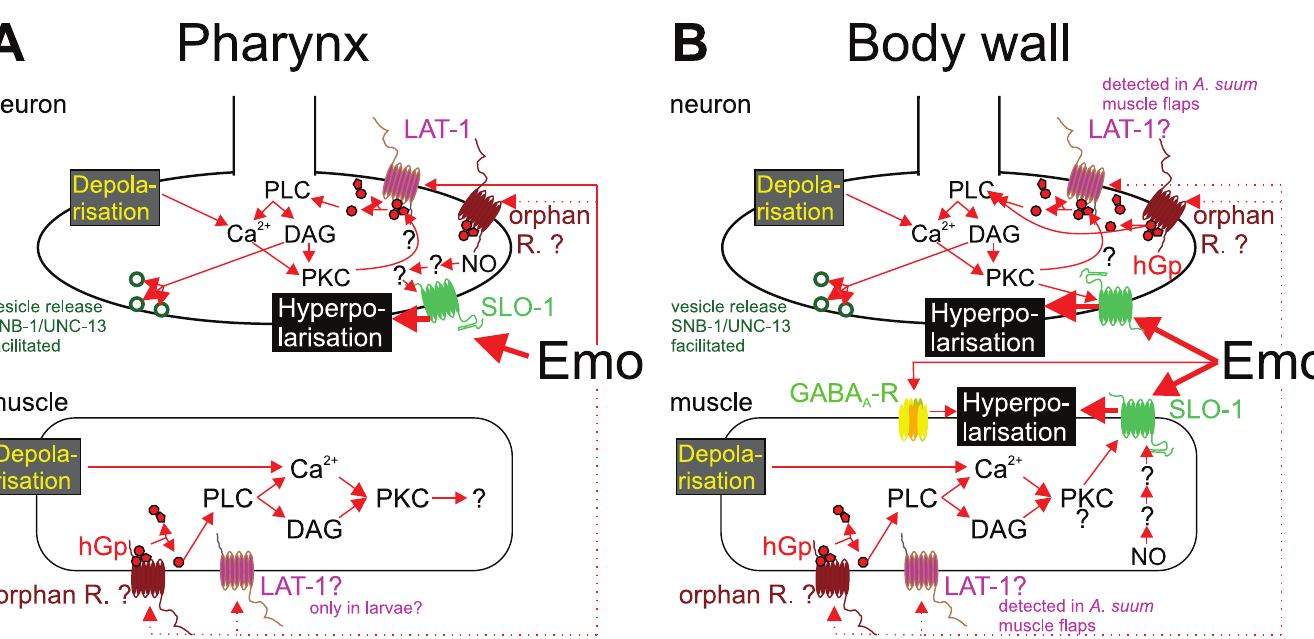
Fig 3. Graphical summary describing the signaling pathways potentially involved in Emo effects in nematodes. Signaling pathways are shown separately for pharynx (A) and body wall muscles (B) . In several cases, there is no clear or unequivocal evidence for the presence/activity of the signaling component in the particular compartment. In these cases, question marks and dotted lines indicate these uncertainties. Emo directly interacts with the ionotropic GABA A -R UNC-49 [52], with LAT- 1 [56] and with the voltage-gated Ca 2+ -activated potassium channel slowpoke big K + conductance channel (SLO-1) [59,60].However, Caenorhabditis elegans lines with loss-of-function mutations in unc-49 , lat-1 , or both lat-1 and lat-2 genes display only modest decreases in their Emo sensitivity [55,57,58].In contrast, loss of SLO-1 function in C . elegans leads to complete loss of Emo efficacy, which can be restored by expression of SLO-1 from parasitic nematodes, but only partially by the human orthologue [23,62,63]. This shows that activation of SLO-1 [59,60] is the major effect leading to Emo-induced paralysis as indicated by bold arrows. Activation of SLO-1 or GABA A -R UNC-49 can lead directly to membrane hyperpolarization, and, thus, to reduced excitation. UNC-49 is only expressed on body wall muscles (postsynaptic side) [64]. In contrast, SLO-1 channels can be found on presynaptic nerves innervating both pharynx and body wall muscles, as well as on body wall muscles themselves, being absent from pharyngeal muscles [63]. LAT-1 (and potentially other, unidentified GPCRs [orphan receptors]) is assumed to exert its effects via a signal transduction cascade involving an hGp containing the EGL-30 Gqa subunit, leading to activation of the PLC EGL-8 [56–58].PLC activity hydrolyses PIP2 to DAG and IP3. The latter leads to release of Ca 2+ from intracellular stores. DAG and Ca 2+ are both required to activate PKC- β , which is known to be able to modulate SLO-1 responsiveness [61]. On the presynaptic side, DAG is further known to facilitate release of vesicles via the synaptobrevin SNB-1 and UNC-13, a protein essential for presynaptic vesicle release [57]. In C . elegans , these signaling pathways are also active in presynaptic neurons and postsynaptic body wall muscle cells [58]. In parasitic nematodes, the situation may be different since lat-1 mRNA was detected in Ascaris suum body wall flaps, suggesting that the receptor is expressed in motor neurons and/or body wall muscles [61]. Moreover, NO has been shown to increase potassium currents induced by Emo in A . suum muscle preparations [61]. It is currently unclear how NO exerts its effect since nematode soluble guanylate cyclases, in contrast to the mammalian enzymes, are not activated by NO [65]. DAG, diacyl glycerol; Emo, Emodepside; GABA A -R, γ - aminobutyric acid A receptor; GPCR, G protein–coupled receptor; hGp, heterotrimeric G protein; IP3, inositol 1,4,5-trisphosphate; LAT-1, latrophilin-1; NO, nitric oxide; PIP2, phosphatidylinositol 4,5-bisphosphate; PKC- β , protein kinase C β ; PLC, phospholipase C; SLO-1, slowpoke big K + conductance